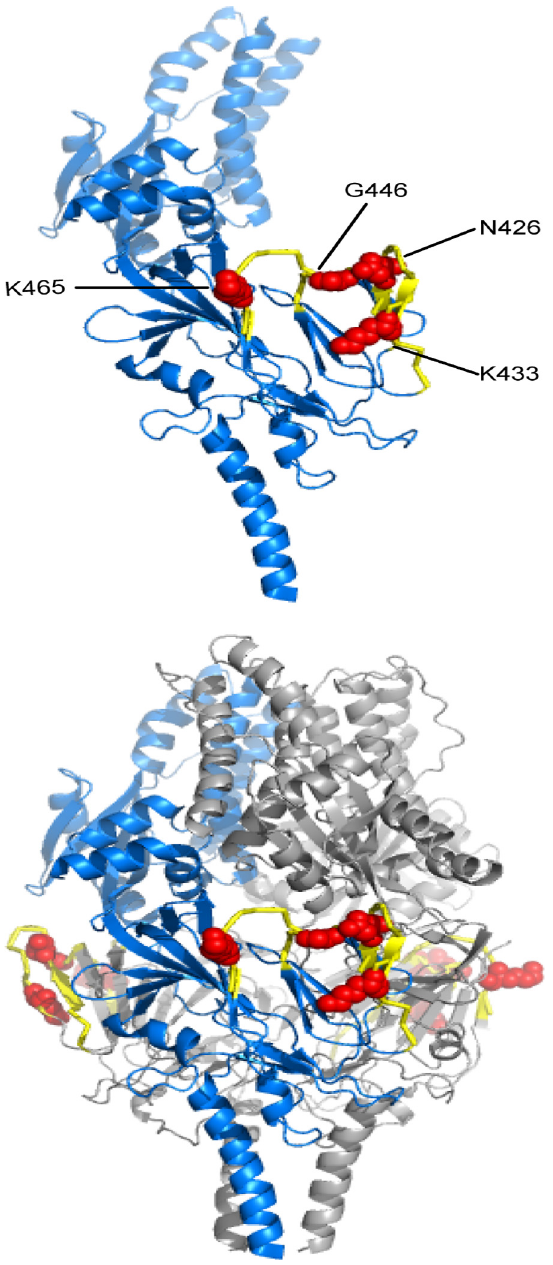
Fig 6. 2E1 binding epitope visualized on the RSV F prefusion structure. The residues identified for 2E1 binding through shotgun mutagenesis are labeled and shown as red spheres and peptides identified through hydrogen/deuterium-exchange mass spectrometry are shown in yellow on the RSV F prefusion monomeric (top panel) and trimeric (bottom panel) structures